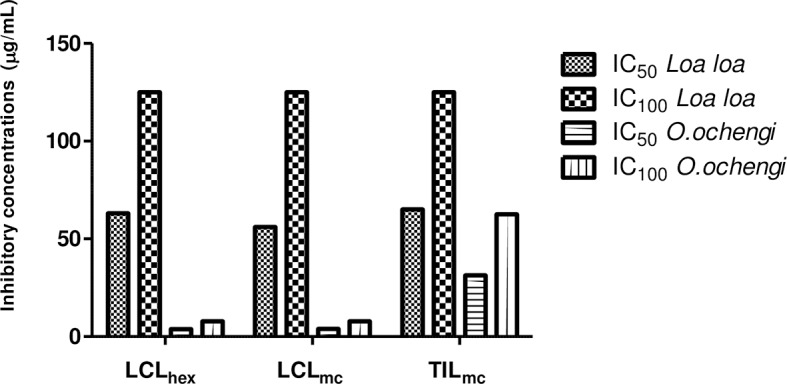
Graphical representation of IC50 and IC100 of active extracts against microfilariae of L. loa compared to the values for O. ochengi.(TILmc: methylene chloride extract from Tamarindus indica leaves; LCLhex: hexane extract from Lantana camara leaves; LCLmc: methylene chloride extract from Lantana camara leaves).